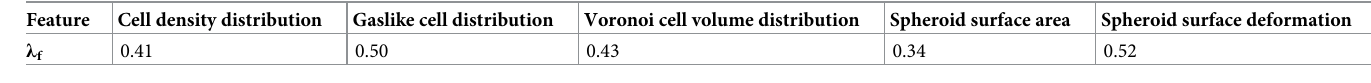
Table 3. Fitted weight factors for each feature contributing to the overall deviation score between two